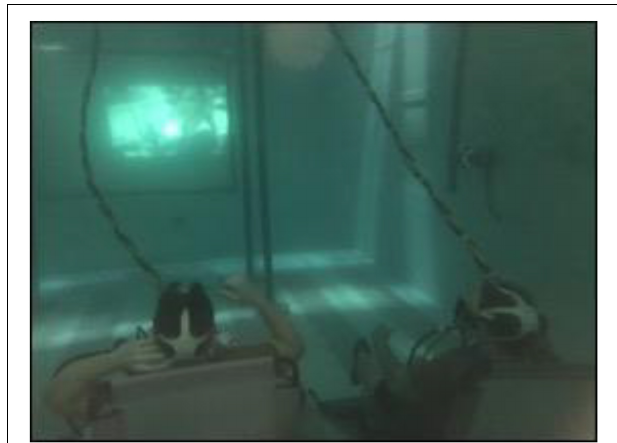
FIGURE 1 | Photo of resting water immersions. Subjects sat in reclining chairs in a thermoneutral (31.7–32.7 ◦ C) water tank (15-feet) for 6 h. 100% oxygen was fed from the surface via hoses to the